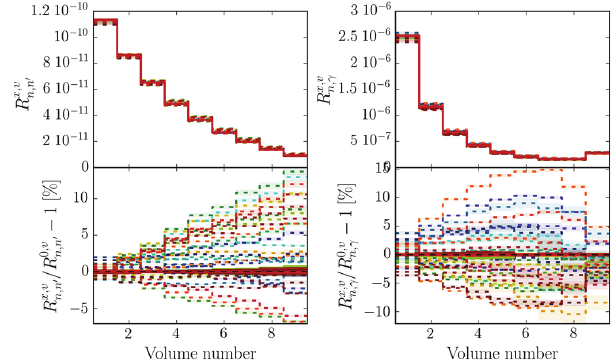
Fig. 9. Reaction rates in the foil detectors for the indium inelas- tic (top-left) and capture (top-right) reactions; the differences between each ACE file and the first ’reference’ ACE file of the iron and the aluminium are represented in colours (middle) respectively in dashed and solid lines.